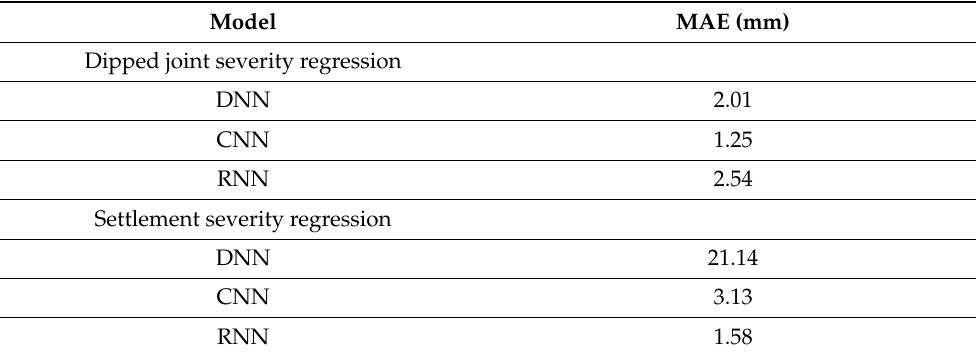
Table 13. Performance of each model for estimating the size of dipped joint and